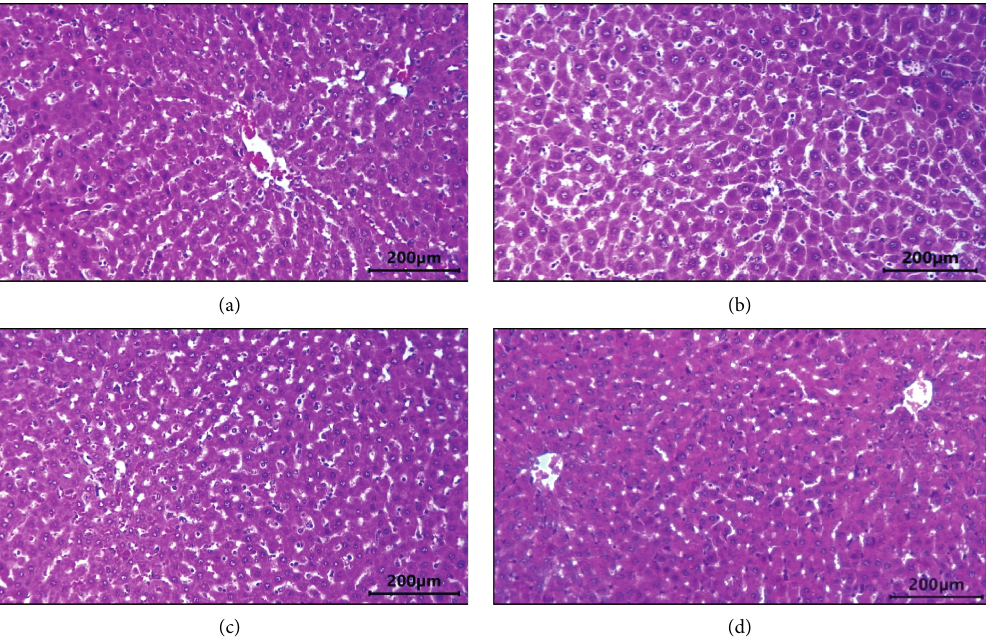
Figure 2: The liver histology after administration of neem leaf ethanolic extracts in male rats: (a) control group, (b) treated group � 100mg/ kg, (c) treated group � 200mg/kg, and (d) treated group � 300mg/kg.